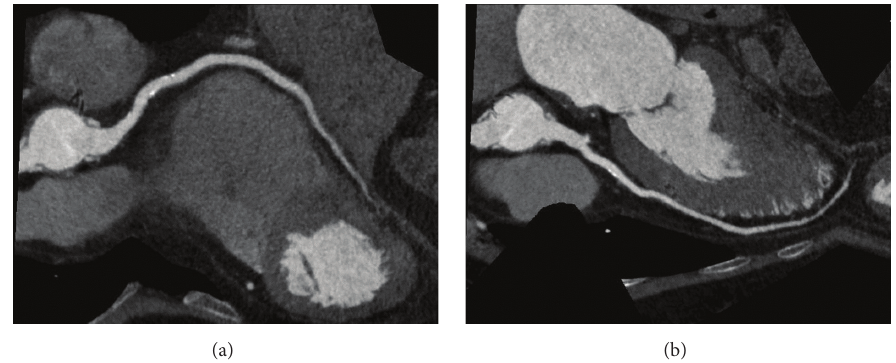
Figure 3: Presurgical screening coronary computed tomography angiography (RR interval = 1114ms) performed in Target CTA mode on a 61-year-old male with a history of aortic valve replacement. Curved multiplanar reconstruction images show the right coronary (a) and left anterior descending arteries (b) with minimal motion artifacts. The diagnostic phase was 68% for calcium scoring scan and 69.1% for coronary computed tomography angiography. The virtual window of 75% exposure was calculated as 70.0–80.4%, which does not include the CCTA diagnostic